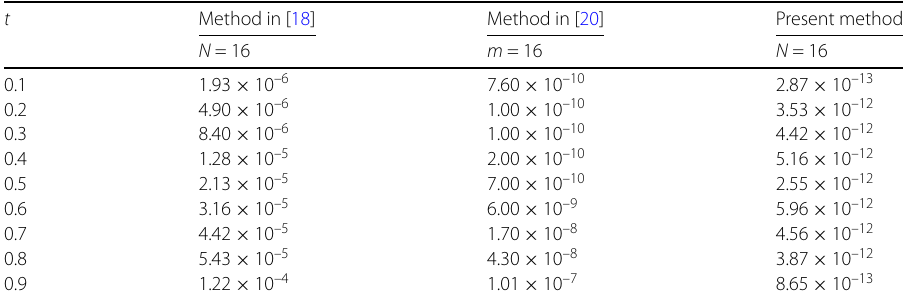
Table 4 Comparison of absolute errors of the present method with the Taylor method for Example